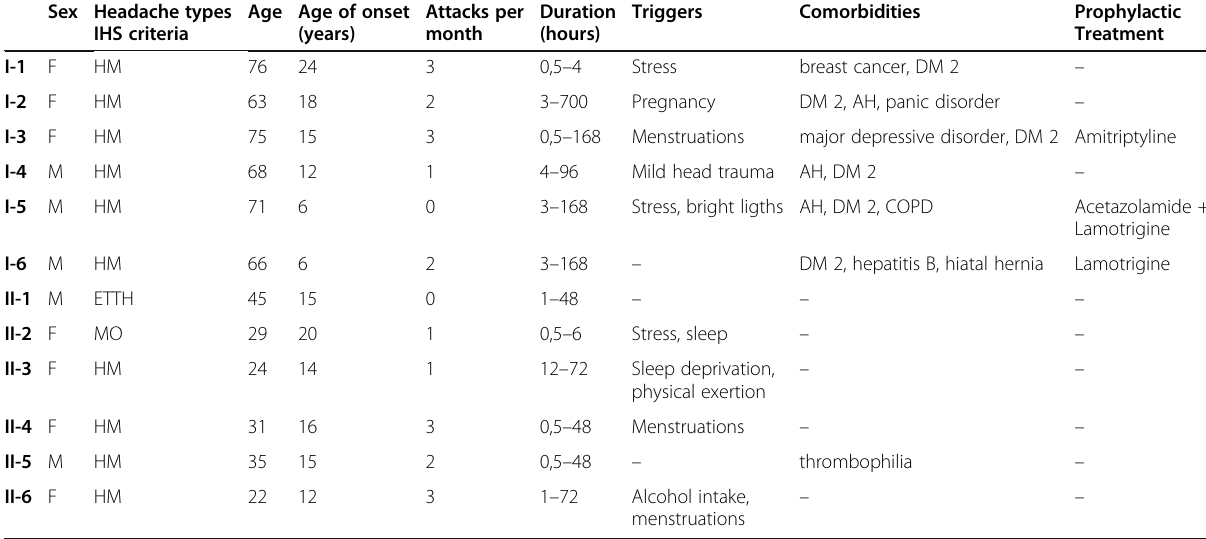
Table 1 Demographic, clinical characteristics and current prophylactic treatment of the 12 patients with the CACNA1A -p.Thr501Met mutation Sex Headache types IHS